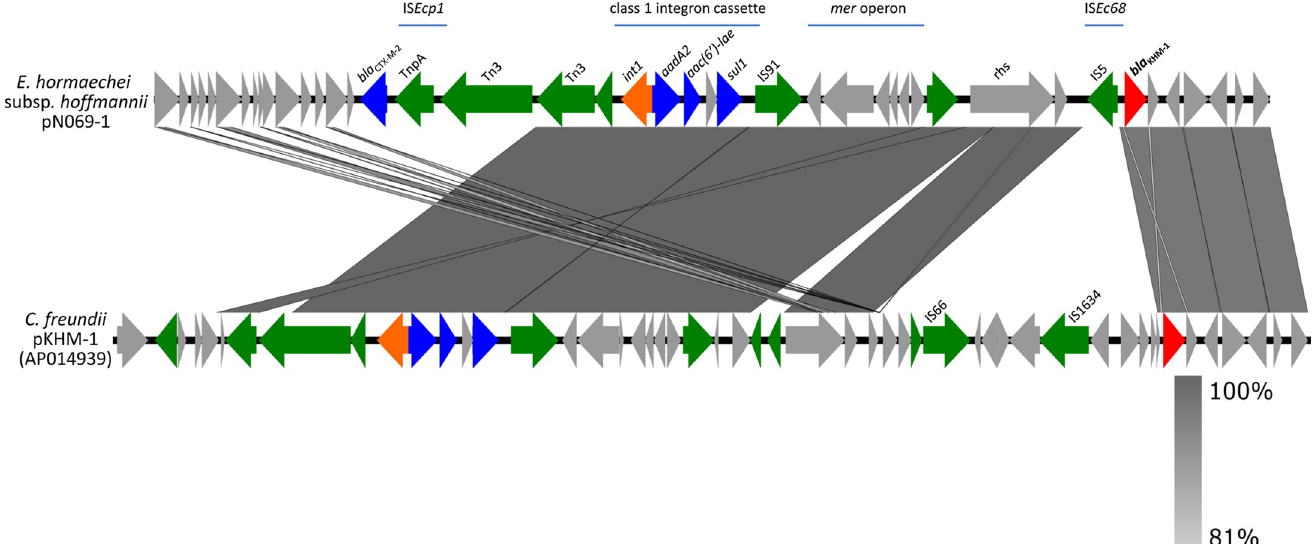
Fig 3. Genetic structures of antimicrobial resistance regions. The bla KHM-1 surrounding antimicrobial resistance region of pN069-1 (about 36.1 kbp) was aligned with that of pKHM-1 (AP014939) [4]. Red, bla KHM-1 ; blue, other antimicrobial resistance genes; green, transposase and recombinase genes; orange, integrase genes; gray, other genes or coding